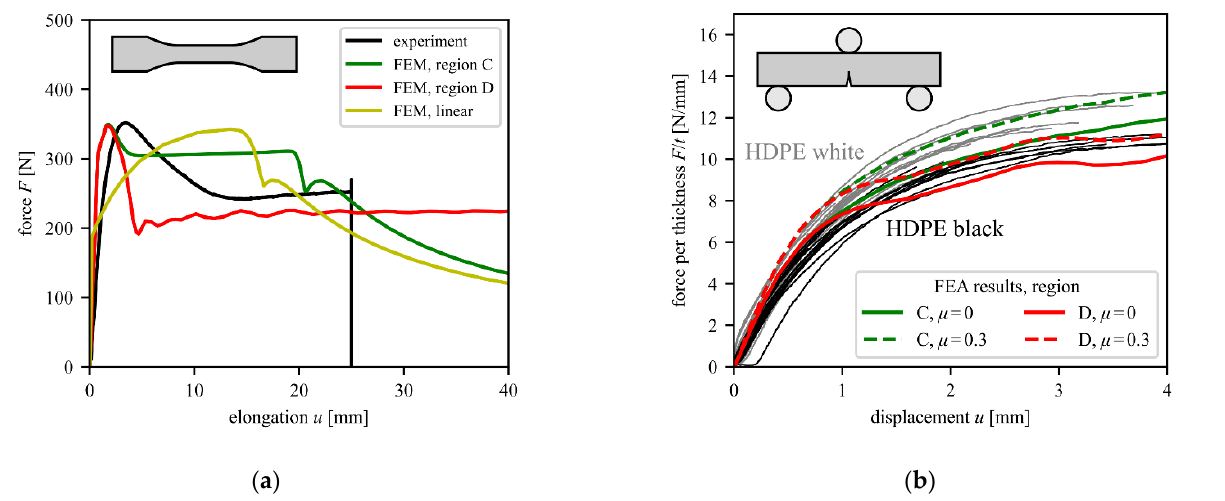
Figure 5. ( a ) Force – elongation curves of the tensile test and the corresponding FE simulation model using the fitted elastic-plastic material models and ( b ) study of the influence of the roller-specimen friction coefficient on the force – displacement curve of the SENB specimen with bulk white HDPE material. The continuous gray and black lines represent individual measurements to illustrate the expected scatter of experimental data.